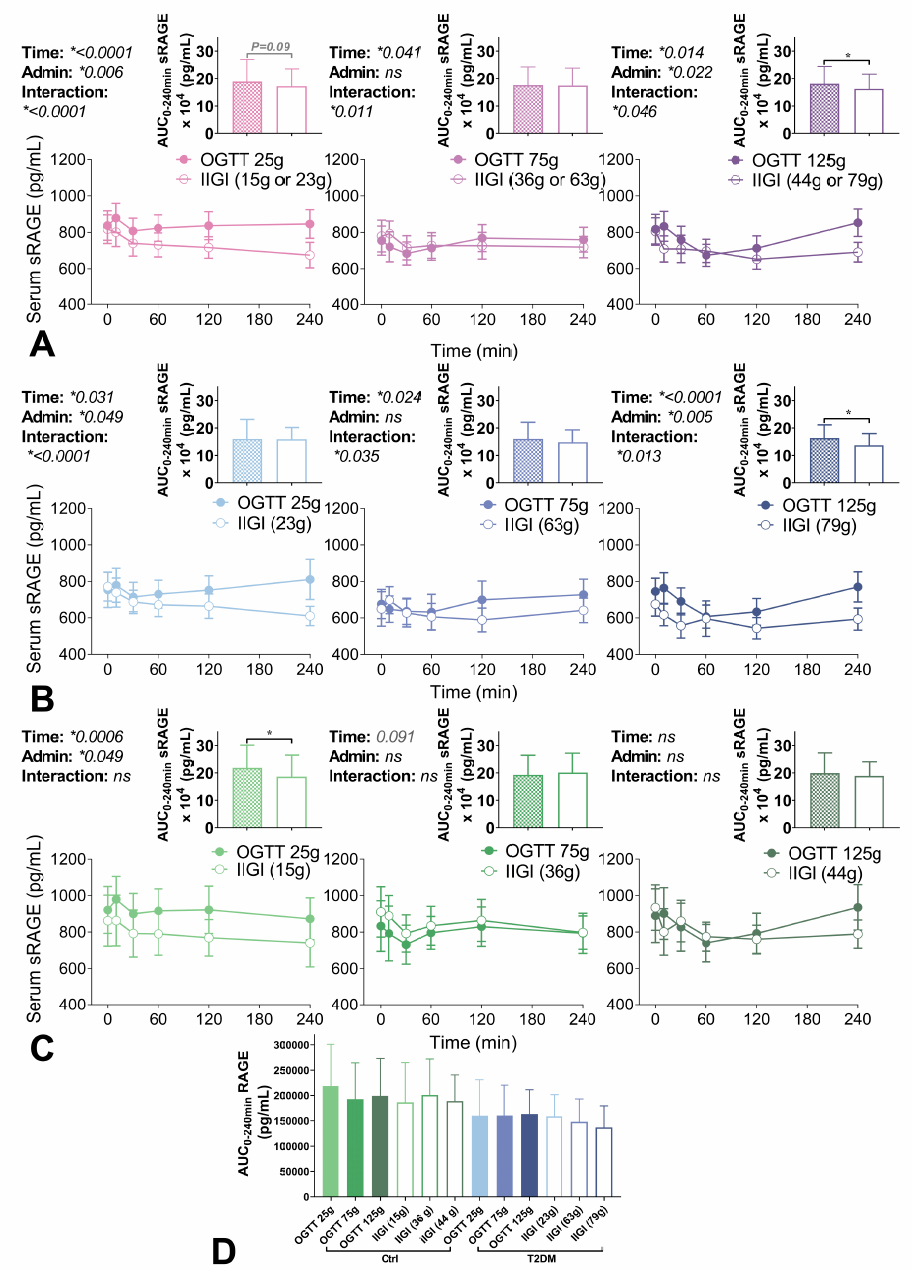
Figure 1. Circulating soluble receptor for advanced glycation end products (sRAGE) concentrations during paired oral glucose tolerance tests (OGTT) and isoglycaemic intravenous glucose infusions (IIGI) at di ff erent glucose dosages. Three OGTTs (25 g, 75 g or 125 g; filled circles / bars) and three matched IIGI (open circles / bars) were performed over 240 min (min) in ( A ) all participants ( n = 16, purple), ( B ) participants with recently diagnosed type 2 diabetes ( n = 8, blue) and ( C ) matched controls ( n = 8, green). Curves show mean ± SEM values for sRAGE across time and were analysed by mixed model. p values for individual e ff ects of time, administration (admin; oral vs intravenous) and interaction terms are shown above (left) each curve (* p < 0.05; ns denotes no significant di ff erence). Area under the curve (AUC) was calculated for curves and presented above as bar graphs showing mean ± SD. AUC were analysed by T test (* p < 0.05). ( D ) shows all AUC sRAGE 0–240 min for controls (green) and individuals with type 2 diabetes (blue) for all glucose doses and administration routes (OGTT filled bars, IIGI open